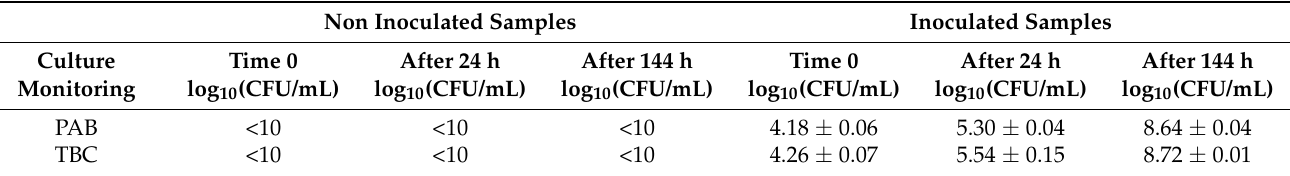
Table 1. Monitoring of the number of total bacteria count (TBC) and Pseudomonas at the point of inoculation, after 24 h and 144 h in milk at 6 ◦ C. Non Inoculated Samples Inoculated